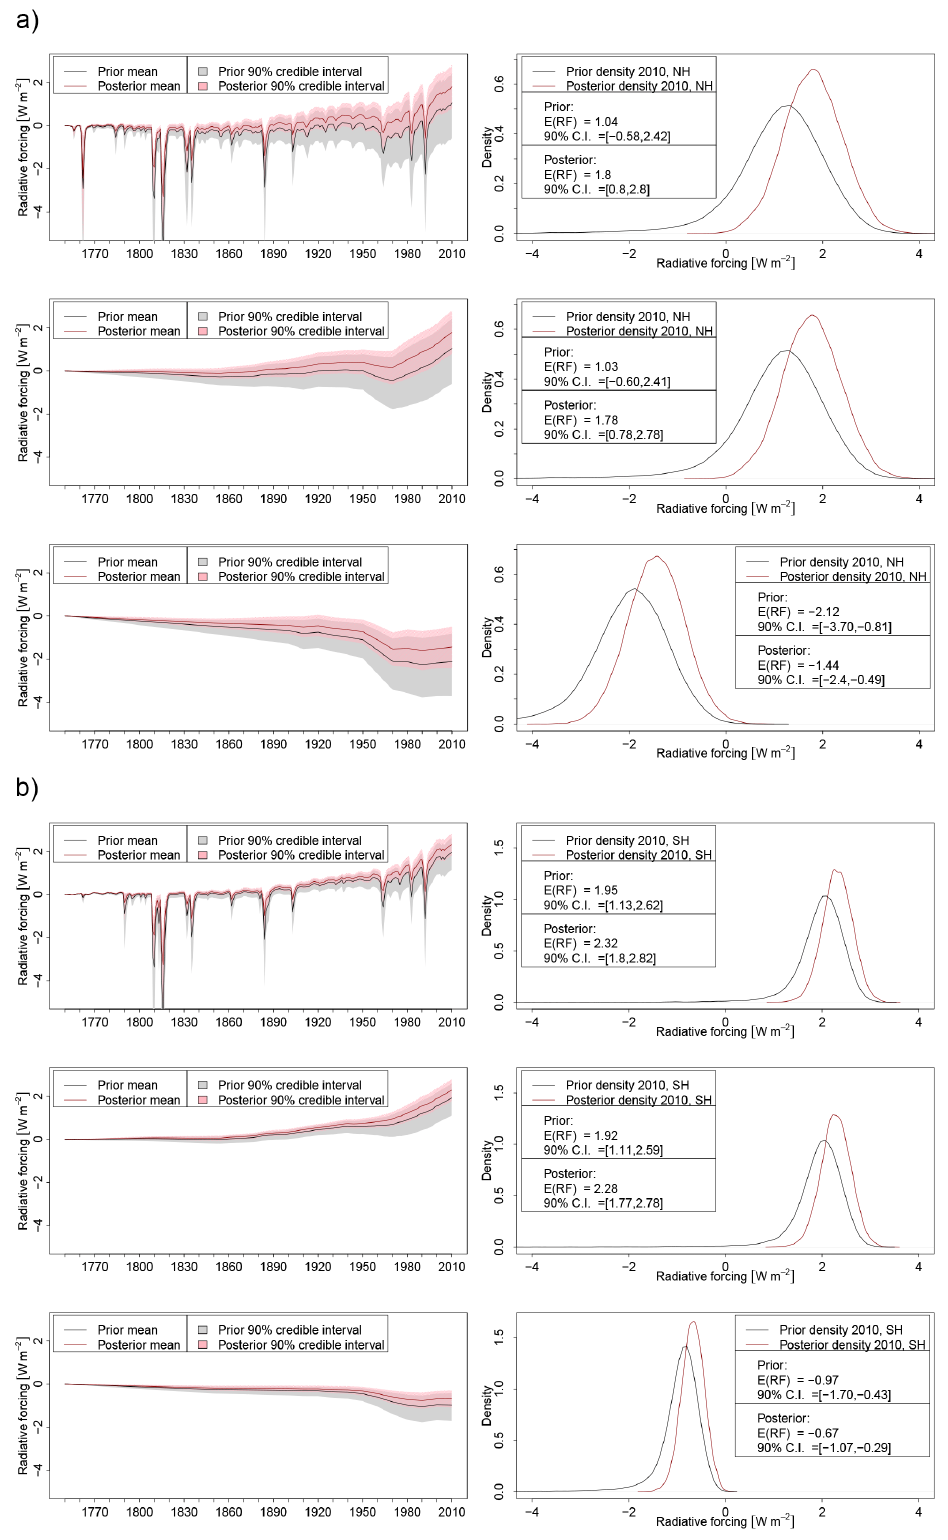
Fig. D1. (a) Prior and posterior distribution of the RF time series and PDF of RF in 2010 for the Northern Hemisphere for total RF (upper panel), anthropogenic RF (middle panel) and total aerosol effect (direct effect, cloud albedo effect, cloud lifetime effect and semi-direct effect) (lower panel) from the main analysis. Red colour for the posterior distribution and black lines and grey shadings for the prior distribution; (b) as (a) , but for the Southern